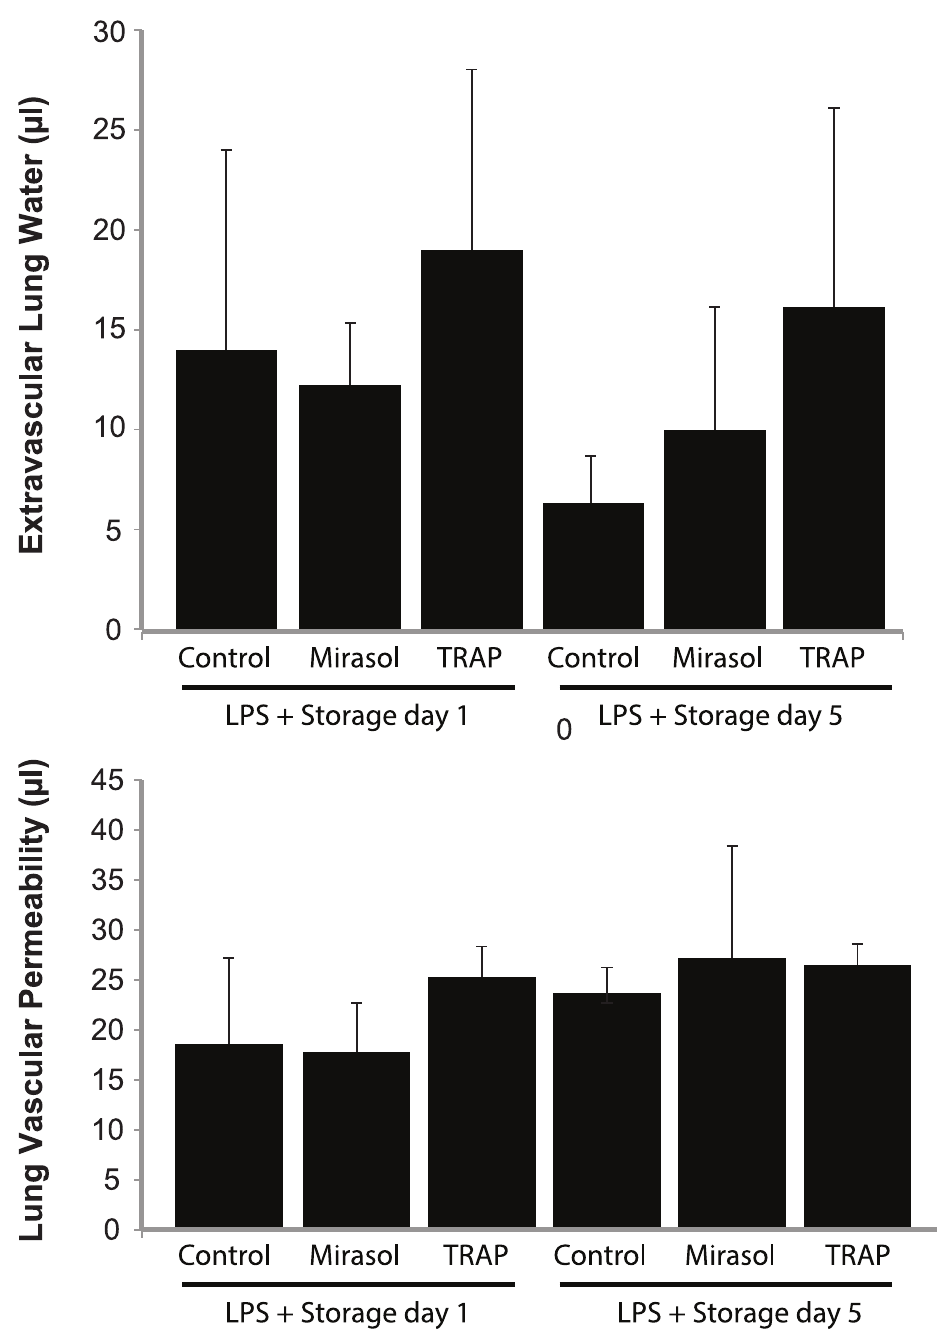
Fig 4. Lung injury in control, Mirasol PRT, and TRAP-treated human platelets transfused into LPS-primed NOD/SCID mice. A. Extravascular lung water in LPS-primed (0.1 mg/kg i.p.) NOD/SCID mice transfused with 10 8 human platelets (control vs. Mirasol PRT vs. TRAP-activated) on day 1 or day 5 of storage. B. Lung vascular permeability to 125 I-albumin (i.v.) in LPS-primed (0.1 mg/kg i.p.) NOD/SCID mice transfused with 10 8 human platelets (control vs. Mirasol PRT vs. TRAP-activated) on day 1 or day 5 of storage. Mean ± SD. n = 5 per group.